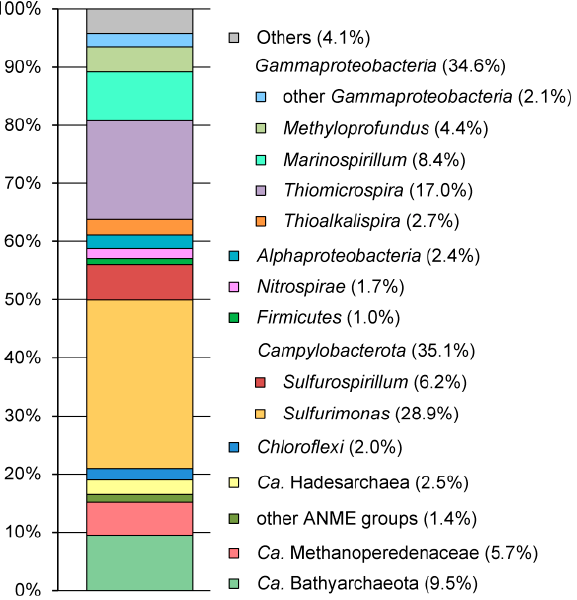
Figure 2. The relative abundance of taxonomic groups of microorganisms according to 16S rRNA gene profiling.